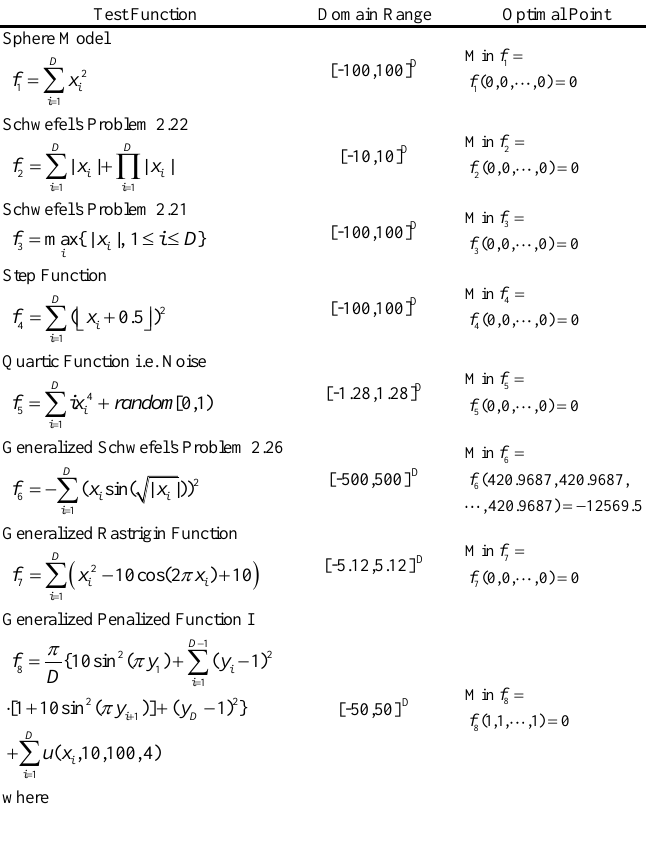
Test Function Domain Range Optimal Point Sphere Model